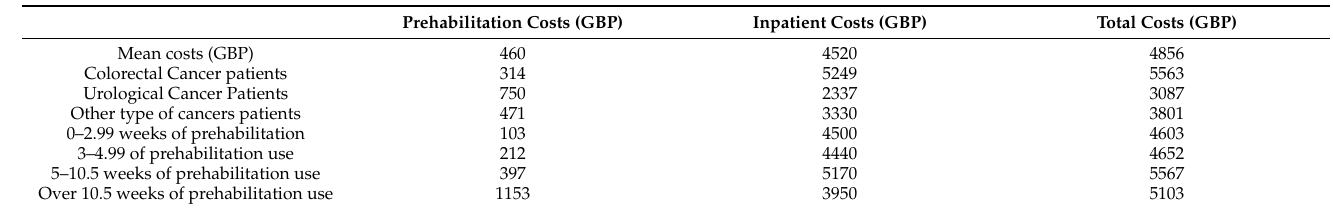
Table 6. Mean prehabilitation, inpatient and total cost of participant groups, according to their cancer diagnosis and total costs in each Prehab use duration band (in